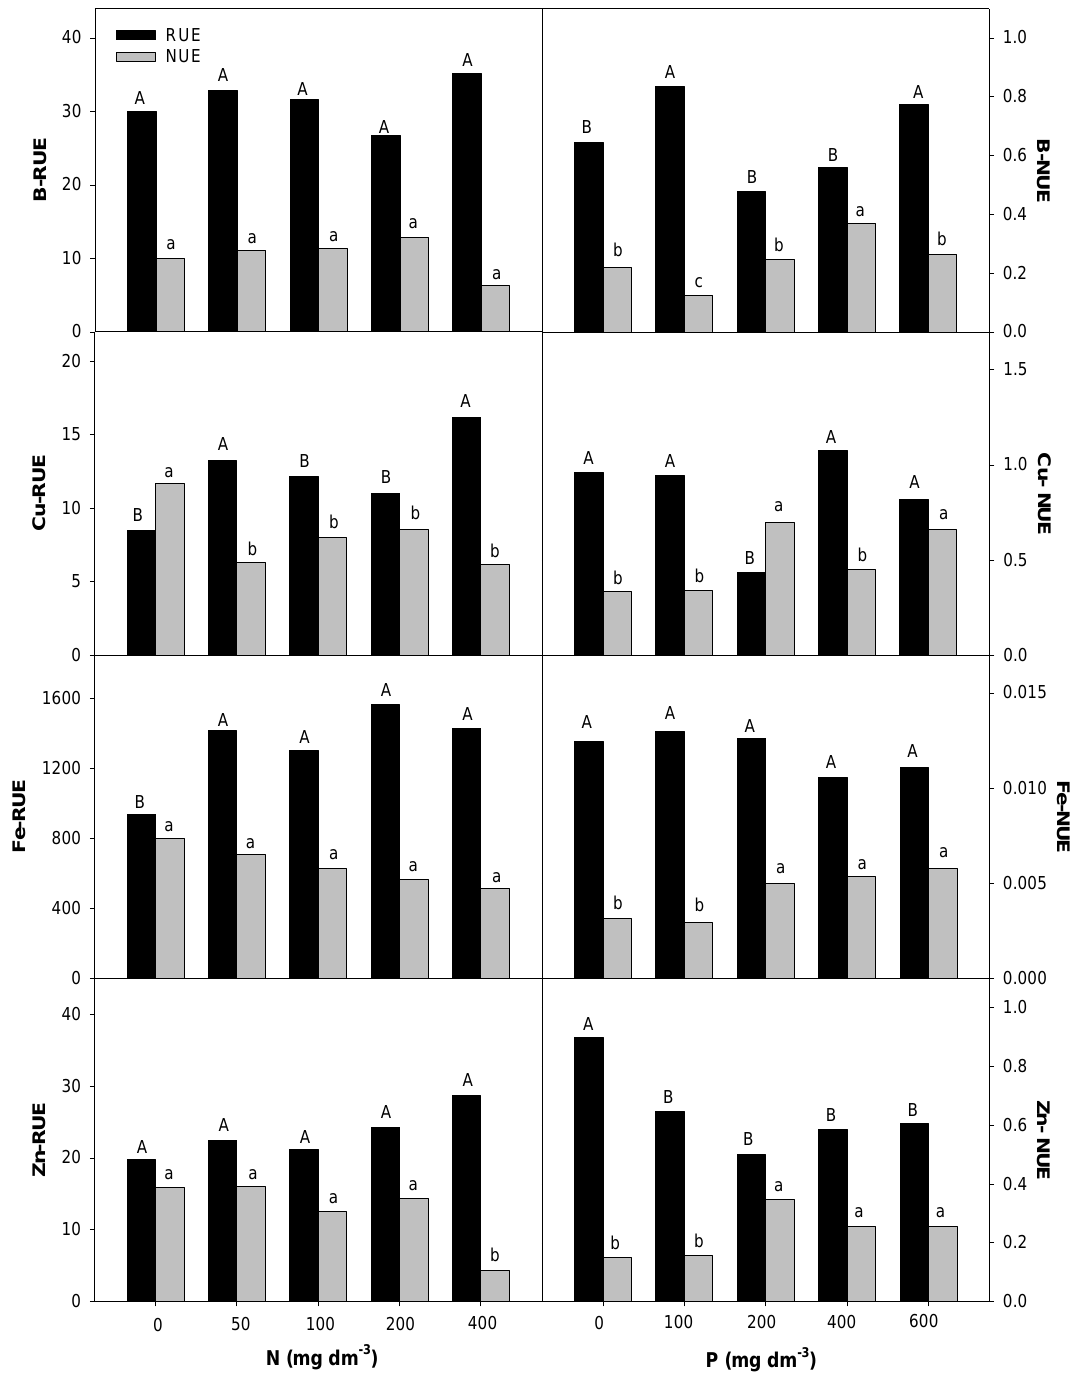
Figure 7. Root uptake efficiency (RUE) and nutrient use efficiency (NUE) for micronutrients in E. dysenterica seedlings. Root uptake efficiency (RUE, mg g⁻ 1 ) and plant nutrient use efficiency (NUE, g 2 g − 1 ) for the micronutrients boron (B), copper (Cu), iron (Fe), and zinc (Zn) in Eugenia dysenterica DC seedlings grown at varying rates of nitrogen and phosphorus for 278 d. Bars represent means ( n = 4). Means followed by the same letters, uppercase for RUE and lowercase for NUE, do not differ by the Scott-Knott clustering test ( p > 0.05).